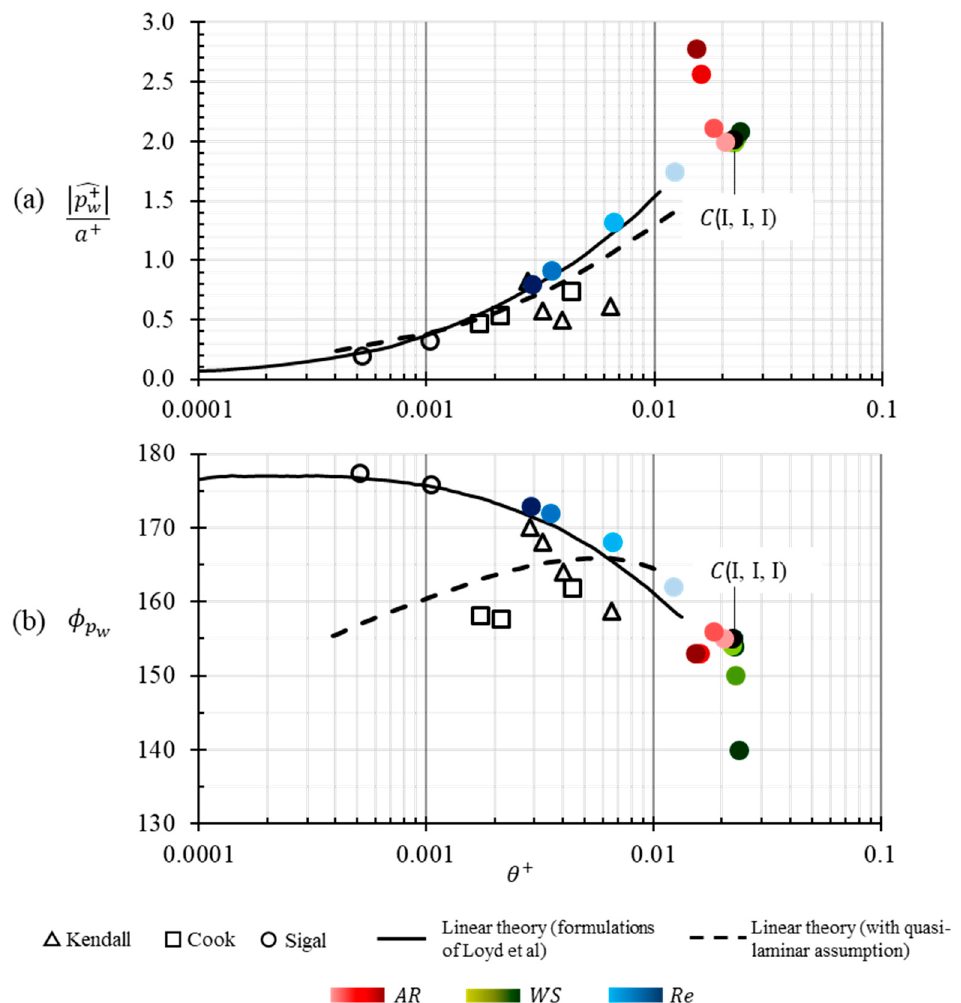
Figure 5. Comparison of theory and experimental data with current study for; ( a ) normalized non-dimensional pressure amplitude on the bottom wall, and ( b ) phase-shift of pressure on the bottom wall, plotted against non-dimensional wave number. All color-coded data represents results from current study. All data excluding the color coded data is reproduced from Thorsness [4].